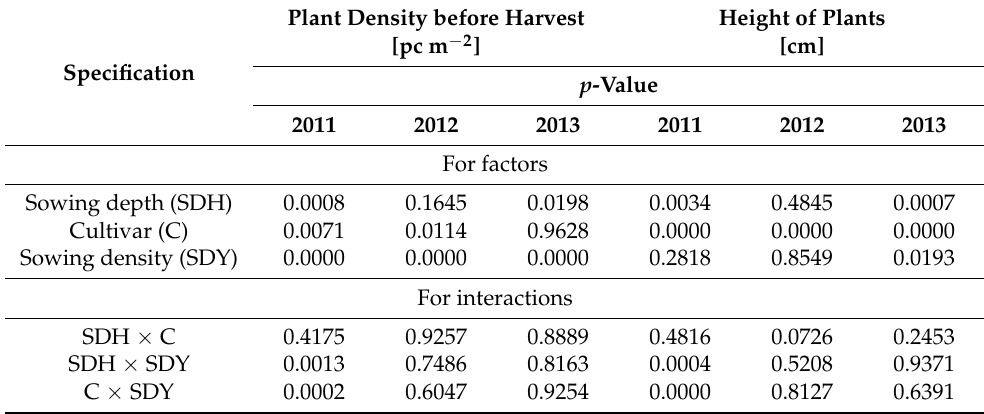
Table 5. Effect of examined factors on plant density and height of plants before harvest.